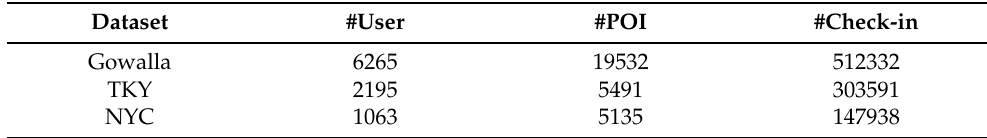
Table 1. Experimental dataset’s statistical